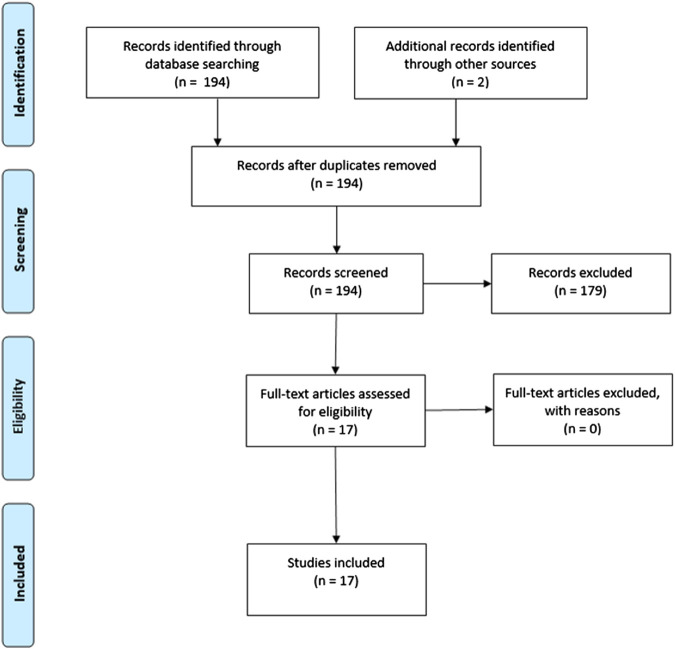
PRISMA flow diagram.